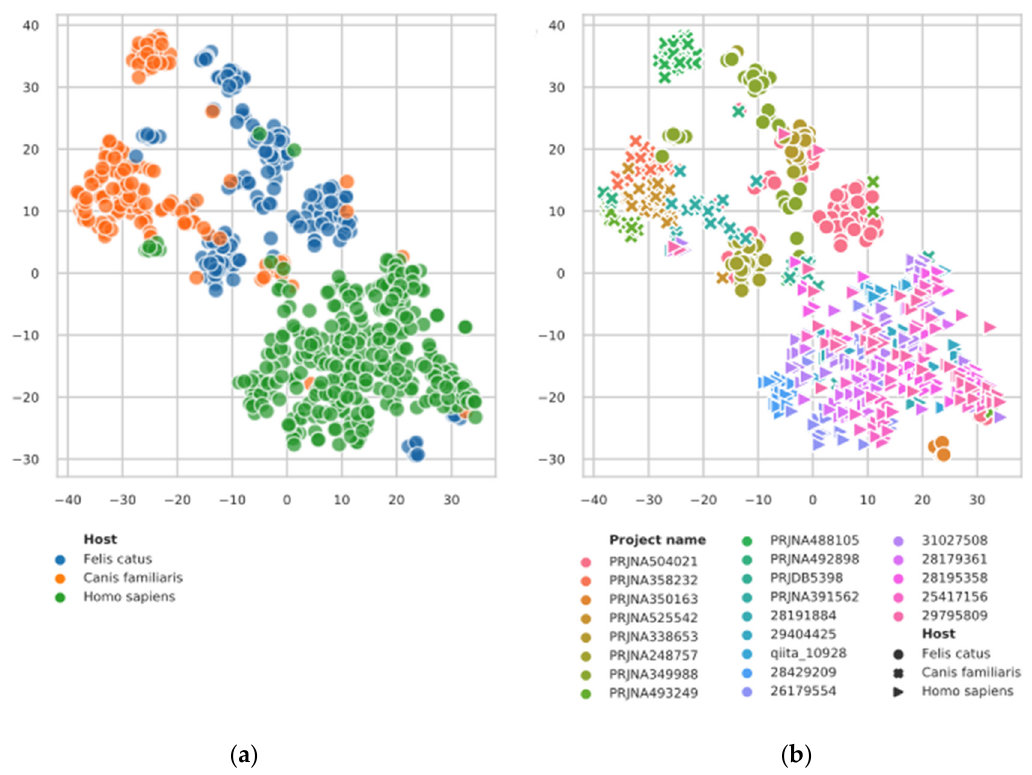
Figure 1. t-SNE plot for the dataset on the genus level. The t-SNE plot was built using 138 most abundant genera of the balanced dataset (see Materials and Methods). The Bray–Curtis dissimilarity between vectors was used. The samples are colored by host ( a ), or by the study name ( b ). On side b, the host is shown by a marker shape. See the in-plot legend for the specific name-color mapping.